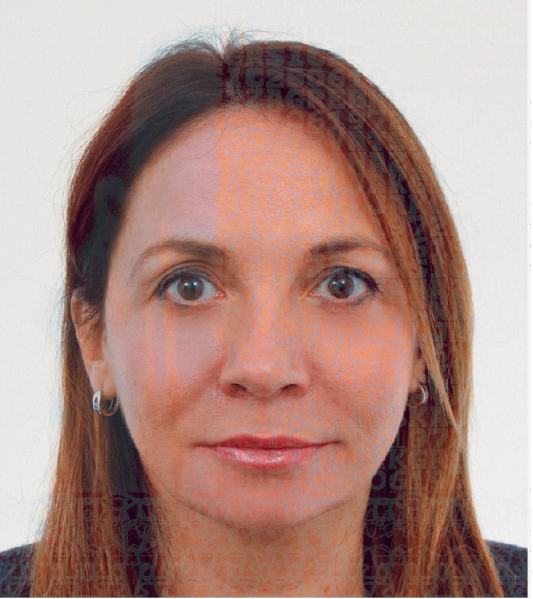
Figure 14. Picture for print (C, M, Y, K), all four channels merged, for the visible and NIR spectrum.